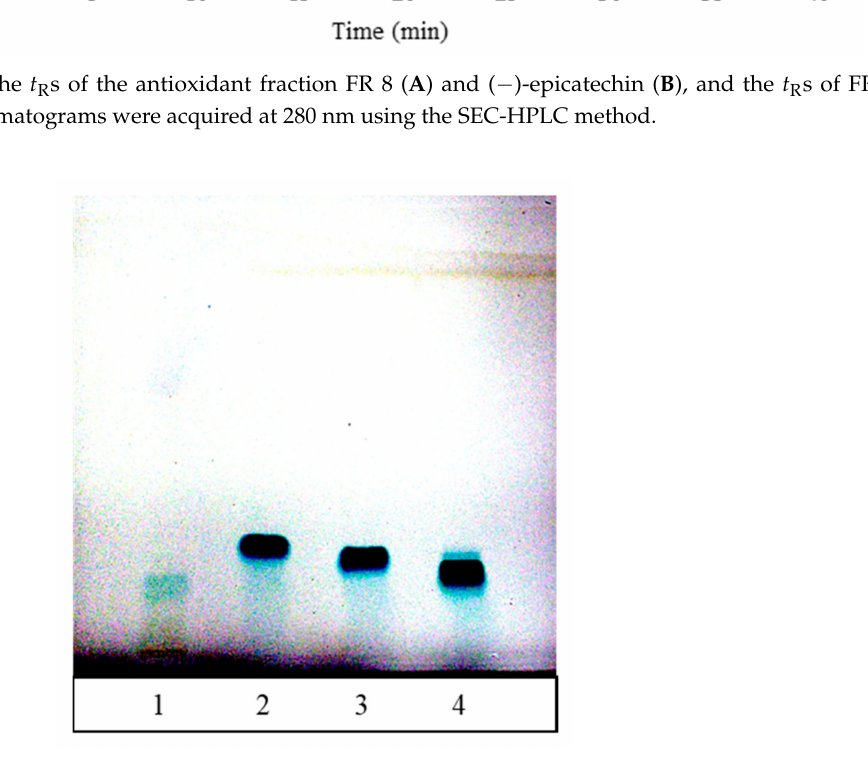
Figure 8. Chromatogram of FR 8 ( track 1 , 40 µ L), (+)-catechin ( track 2 , 400 ng), ( − )-catechin ( track 3 , 400 ng), and ( − )-epicatechin ( track 4 , 400 ng) applied as 8 mm bands on the HPTLC cellulose plate developed with water, derivatized with DMACA reagent, and documented with illumination with white